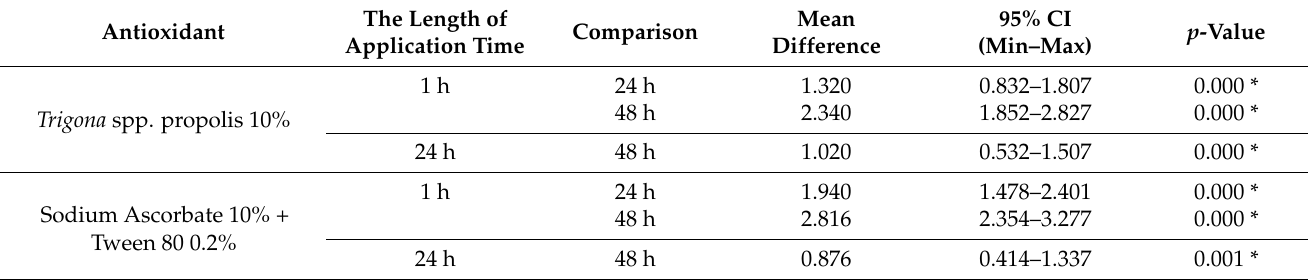
Figure 1. The average distribution of dissolved oxygen based on duration of application time in each antioxidant group. (The difference between the average dissolved oxygen of each antioxidant group during application time was statistically significant at 0.05 level.) Table 1. The test results for application duration times of 1 h, 24 h, and 48 h in each antioxidant